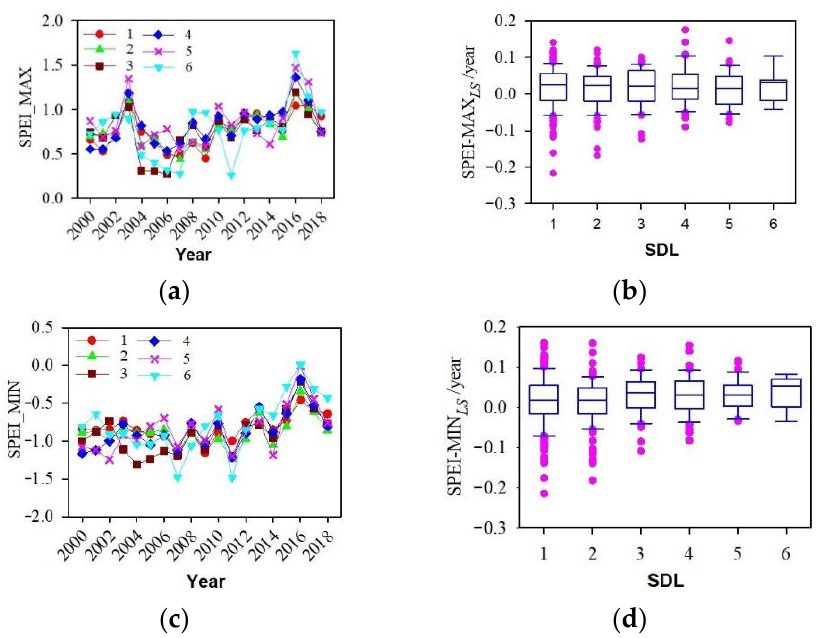
Figure 2. The variations and LSs of SPEI_MAX and SPEI_MIN during the period 2000–2018 at different SDLs. ( a ) Variations in SPEI_MAX. ( b ) LSs of SPEI_MAX. ( c ) Variations in SPEI_MIN. ( d ) LSs of SPEI_MIN. In Figure 2: (1) both average SPEI_MAX and SPEI_MIN vary and fluctuate with